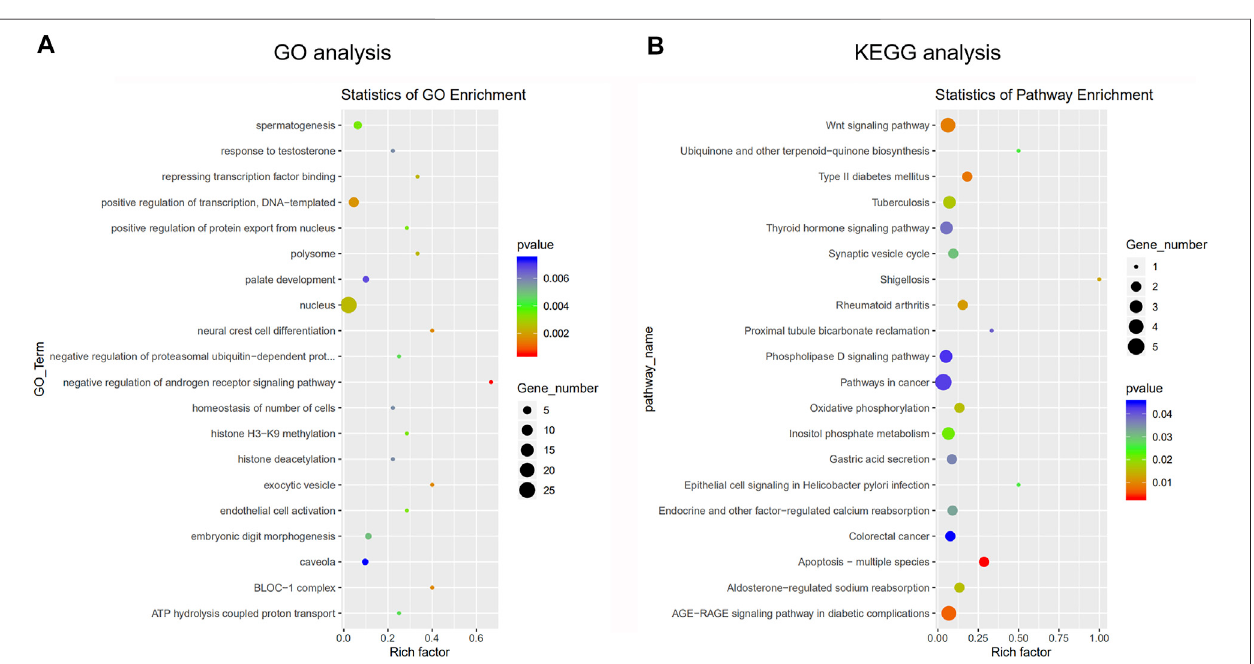
FIGURE 3 | Gene ontology (GO) analysis and Kyoto Encyclopedia of Genes and Genomes (KEGG) pathway annotation of differentially expressed circRNAs betweenyounggroupandoldgroup. (A) Thebubblechartshowsthetop20mostsigni fi cantlyenrichedandmeaningfulGOtermsrelatedtothealteredcircRNAsranged accordingtothepredicted p -values. (B) Thebubblechartshowsthetop20mostsigni fi cantlyenrichedpathwaysdependingonage.Theenrichmentfactoronthe X -axis indicatesthespeci fi cityofapathwayactivatinginoldsamplescomparedwithyoungsamples.ThebubblesizerepresentsthenumberofcircRNAsenrichedinaGO terms or pathway. The red bubble indicates a more signi fi cant GO terms or